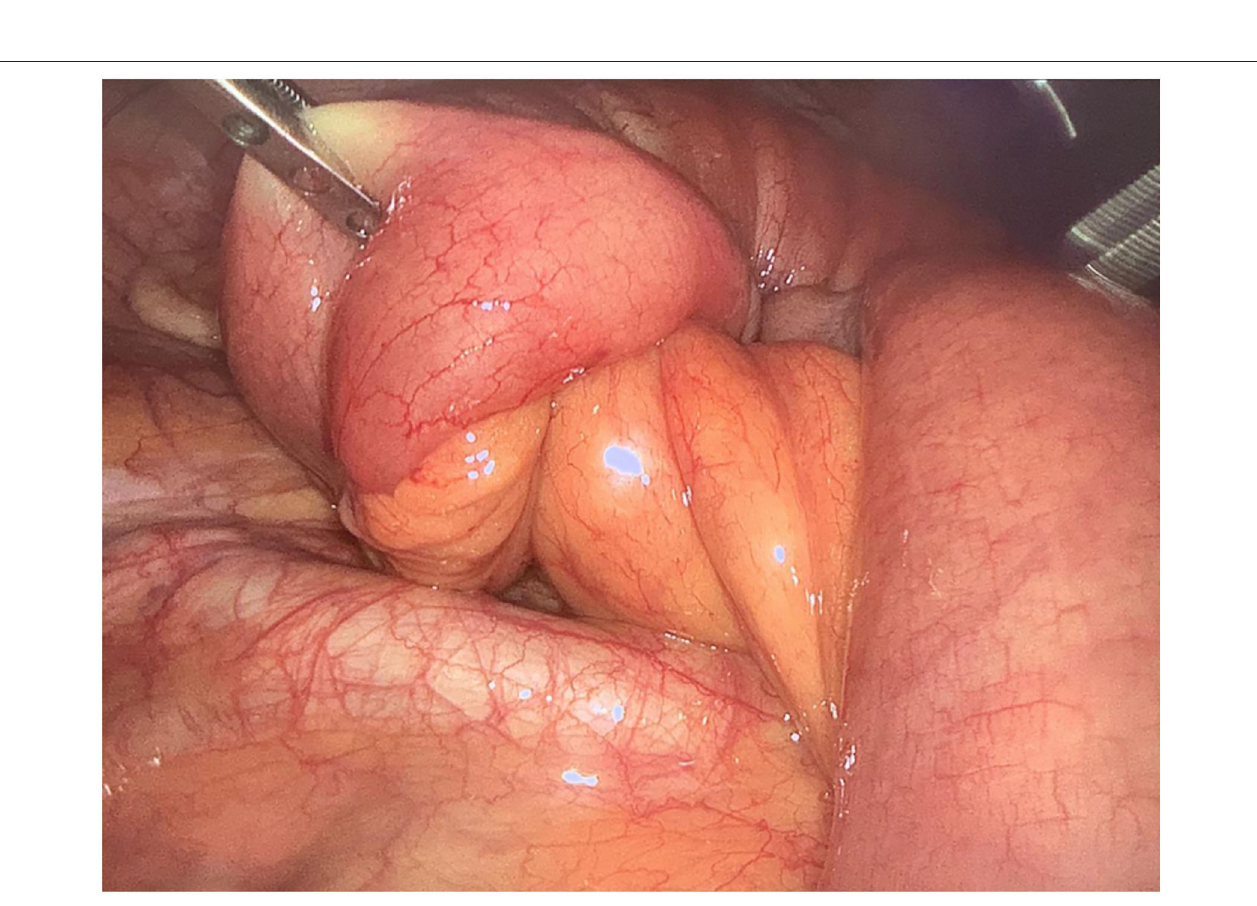
FIGURE 2 | Laparoscopic view of the “lead-point” of the ileo-ileal intussusception.